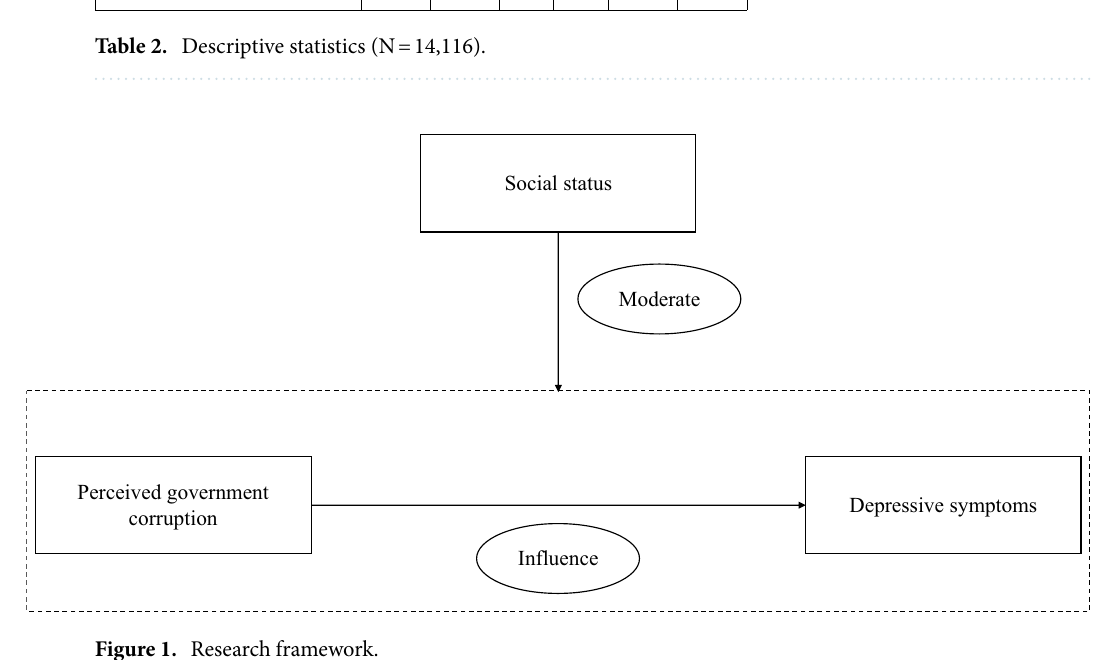
Figure 1. Research